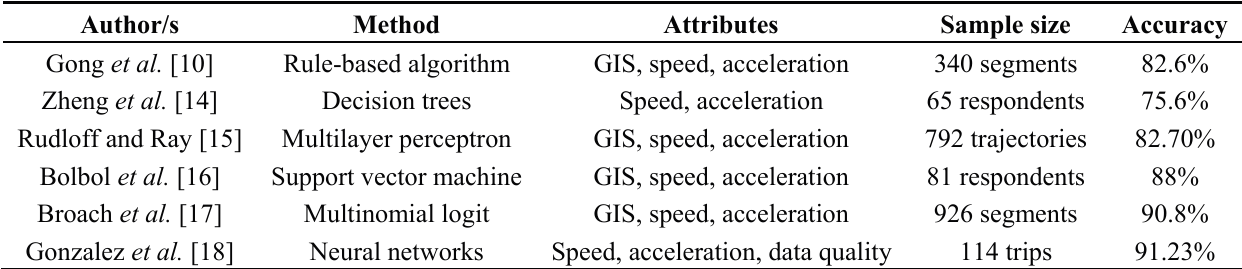
Table 1. Summary of different methods for detecting travel